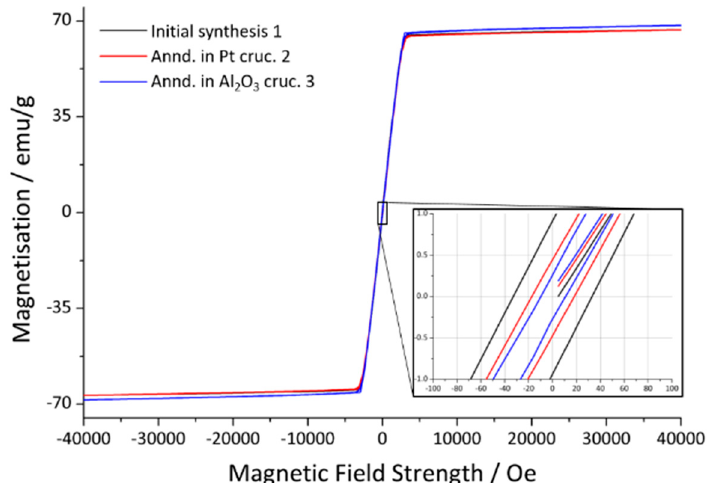
Figure 5. Hysteresis curves of a crystal sample from the initial synthesis (black), after annealing in a platinum crucible (red) and corundum crucible (blue) with the magnetic field applied parallel to the c axis. The area around the origin is magnified to show the coercivity and remanence. Table 6. Saturation magnetization M s , remanence M r and coercivity H c of four investigated samples.